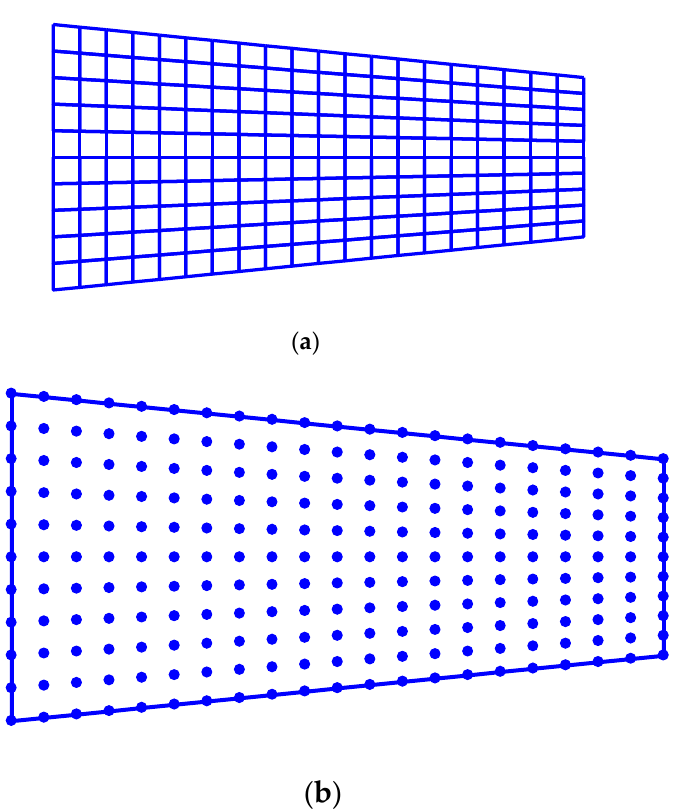
Figure 8. The different node arrangement patterns that are employed to discretize the variable cross-section cantilever beam for different numerical methods: ( a ) mesh pattern used to discretize the variable cross-section cantilever beam for the standard FEM-Q4; ( b ) node arrangement patterns used to discretize the variable cross-section cantilever beam for the RPIM and M-RPIM. Table 5. The first twelve natural frequency values for the variable cross-section cantilever beam computed using different numerical methods.